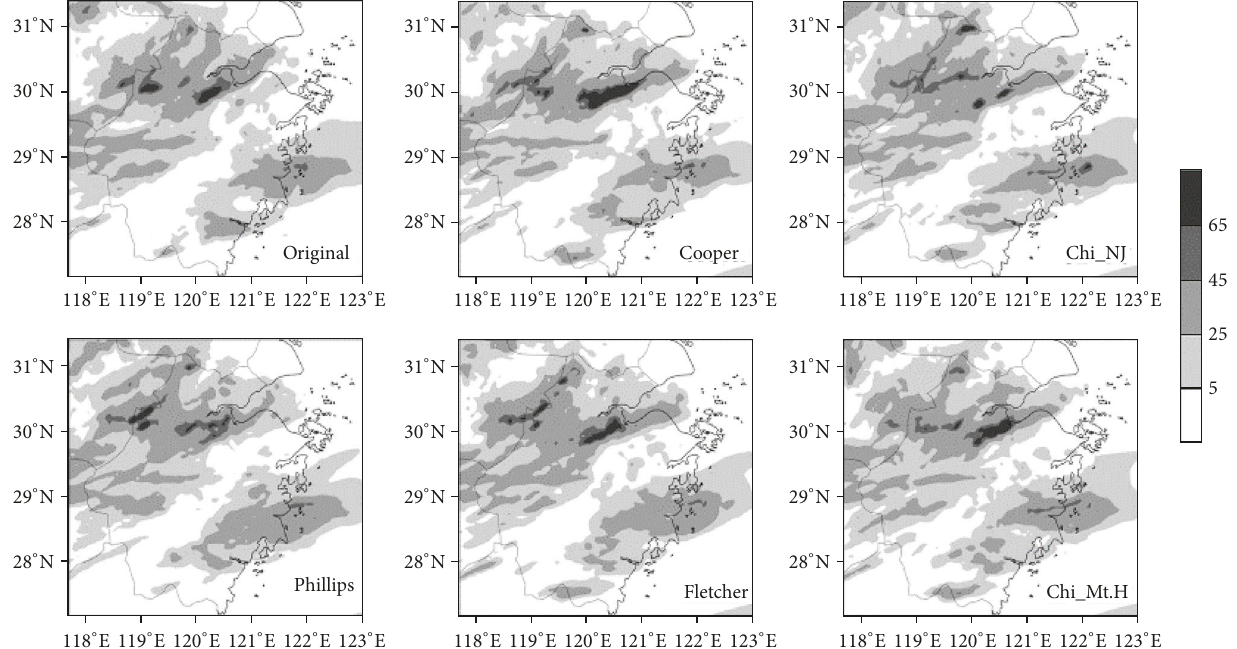
Figure 4: Simulation of the 6-h cumulative precipitation at 20:00 CST on November 9 in the Zhejiang Province based on different ice nuclei parameterizations (unit: